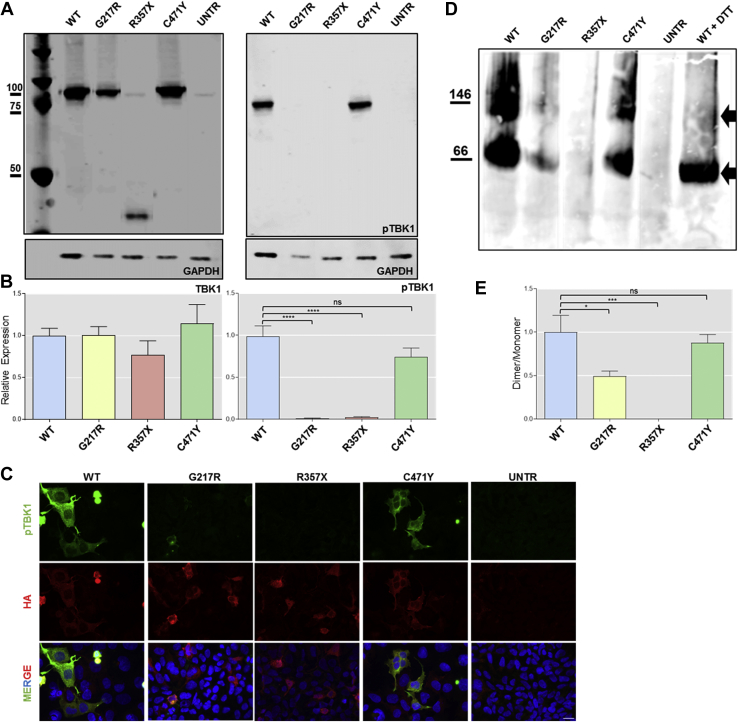
TBK1 p.G217R and p.R357X impair TBK1 phosphorylation and autophosphorylation and might reduce TBK1 homodimerization. (A) Western blot analysis of TBK1 expression levels (left) and pTBK1 (right). (B left) Quantitative analysis of blot in (A) left showing a similar expression level of TBK1 in cells (n = 4). (B right) Quantitative analysis of blot in (A) right showing a significant decrease of expression of pTBK1 in p.G217R and p.R357X (n = 4 analyzed by one-Way ANOVA followed by Dunnett's post test p < 0.0001). (C) Immunocytochemistry of HEK293T transfected with TBK1-WT, p.G217R, p.R357X, and probed for p-TBK1 confirming the result obtained by Western blot analysis (Fig. 3B) (Scale bar = 10 μm). (D) Native gel showing the dimer and monomer (indicated by black arrows) in TBK1-WT and TBK1-C471Y, the weaker dimer and monomer in the p.G217R sample, and no dimer or monomer in the R357X sample. (E) Quantitative analysis of gel in (D) showing significant reduction in dimer formation for p.G217R (positive control on the right TBK1 WT treated with DTT, n = 3, analyzed by one-way ANOVA followed by Dunnett's post test p < 0.05). Abbreviations: TBK1, tank binding kinase 1; WT, wild type. * p = 0.0306; *** p = 0.0006; **** p ≤ 0.0001.